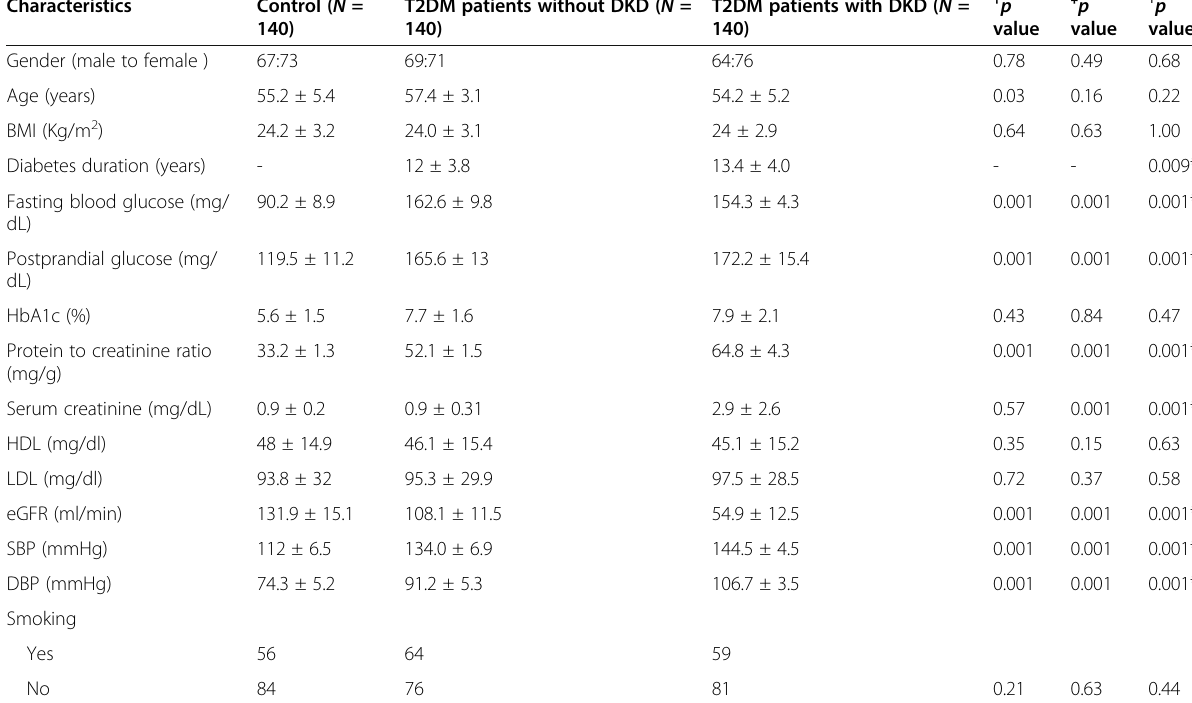
Table 2 Demographic and clinical characteristics of the study subjects